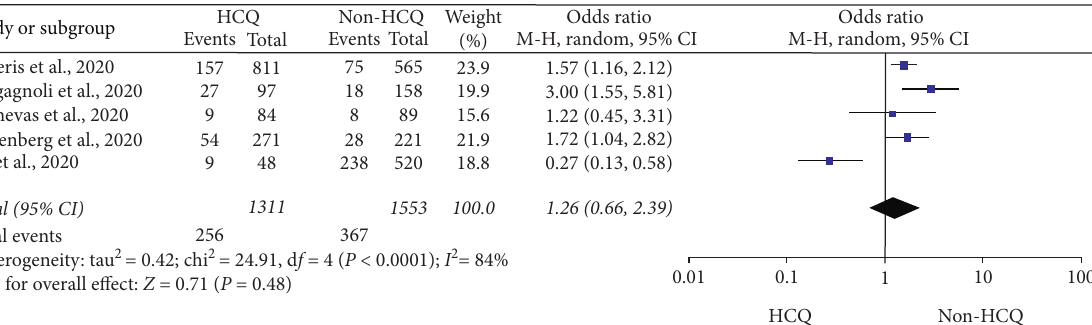
Figure 3: Risk of mortality among COVID-19 patients exposed to HCQ as compared to non-HCQ (standard care).